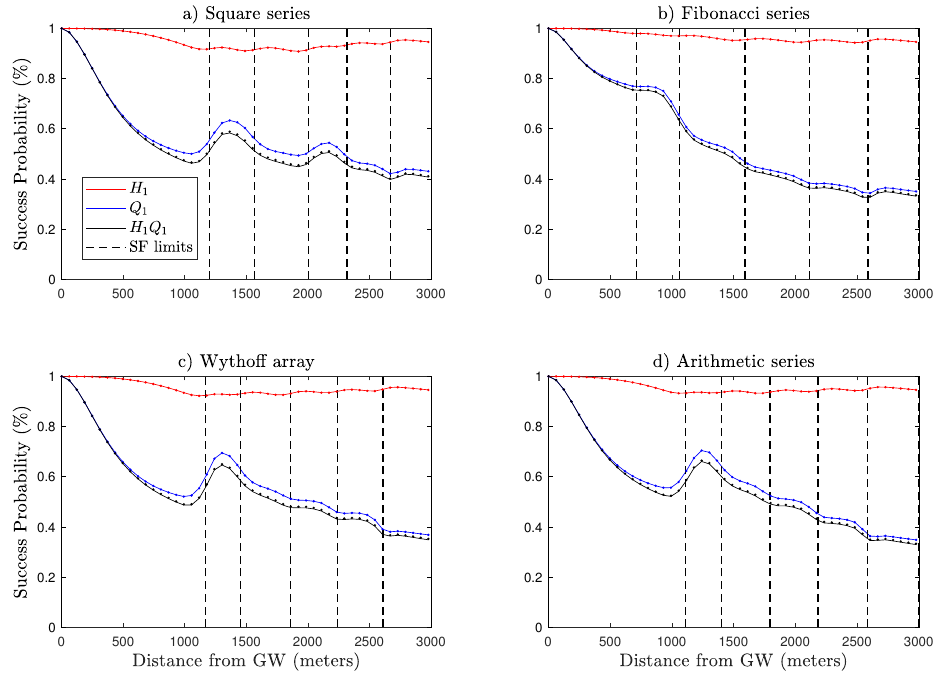
Figure 6. LoRa uplink performance with the proposed SF allocation algorithm for different series and ¯ N = 500 nodes. ( a ) Square series with K = { 49,36,25,16,9 } . ( b ) Fibonacci series with K = { 34,21,13,8,5 } . ( c ) Wythoff with K = { 37,32,24,16,11 } . ( d ) Arithmetic series with K = { 34,28,22,16,10 }